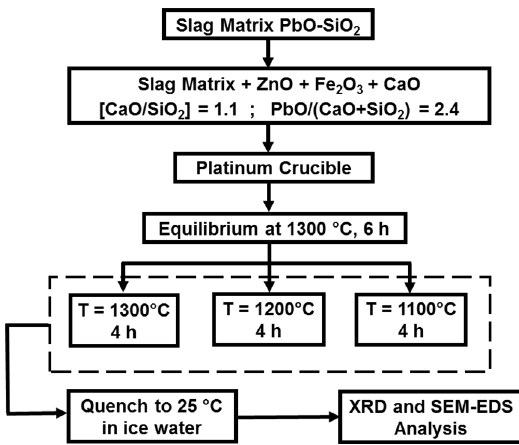
Figure 3. Experimental procedure. Samples of each slag were characterized by X-ray diffraction (XRD Bruker D8 Focus) using Cu K Å) radiation over a 2 θ of 10º to 120º at a speed of 2 min -1